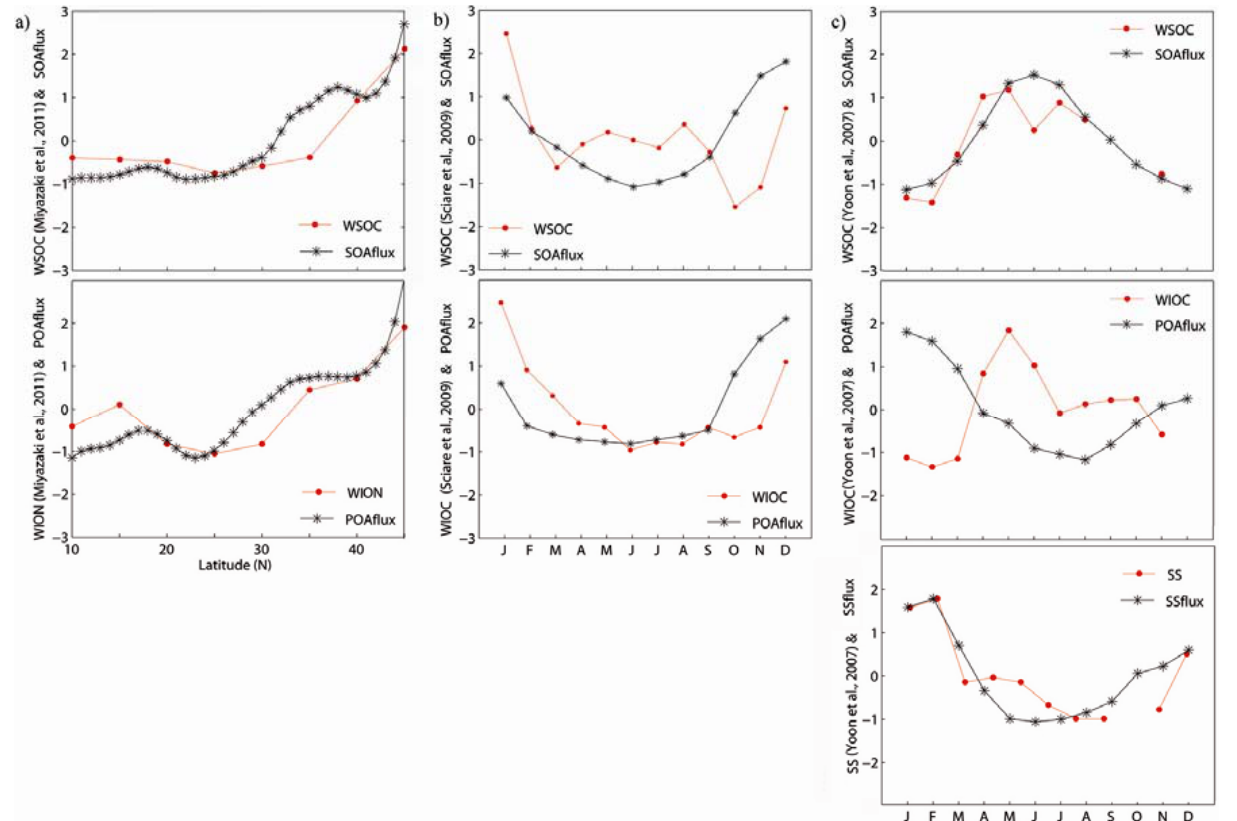
Figure 5 Fig. 5. Validation of aerosol flux parameterizations. (a) Standardized latitudinal series of aerosol water soluble organic carbon